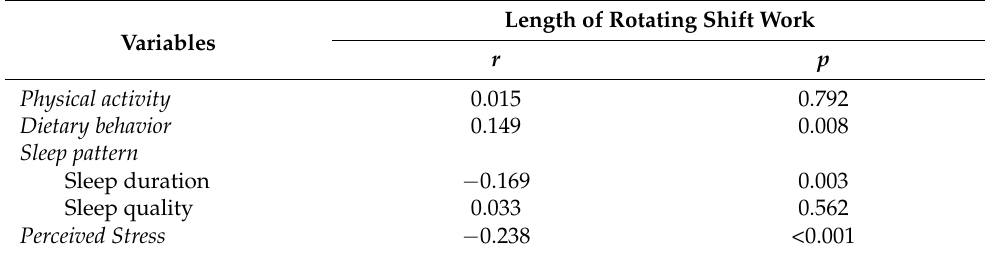
Table 4. Correlations among the length of rotating shift work and lifestyle patterns. Variables